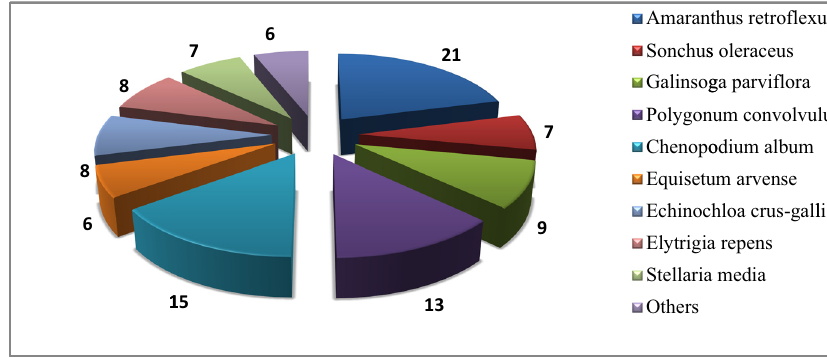
Figure 1: Species composition of weeds in the potato agrocenosis at harvesting, pcs/m 2 ( average for 2017 – 2020 )